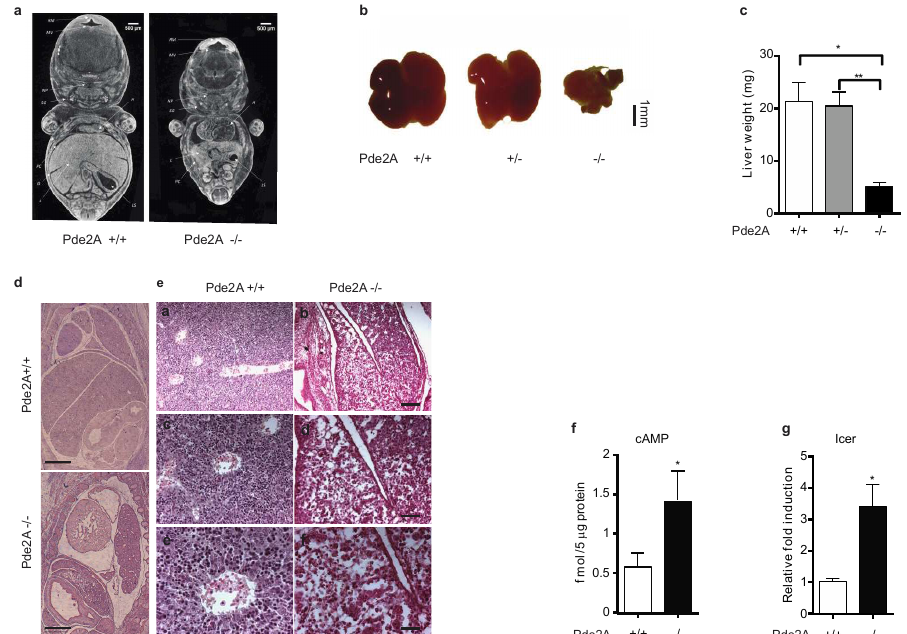
Figure 1. Morphological defects in liver of PDE2A − / − embryos. ( a ) Volume rendering visualization of coronal sections obtained from E14.5 PDE2A +/+ and PDE2A − / − embryos. Sections were chosen referring to the stomach lumen ( LS ) volume. H heart, L liver, PC peritoneal cavity, IS interlobular space, MV mesencephalic vesicle, SG submandibular gland, RM roof of midbrain, NP nasopharynx. ( b ) Representative stereomicroscope picture of livers isolated from E14.5 PDE2A +/+ , PDE2A +/ − and PDE2A − / − embryos. The liver of PDE2A − / − is hypoplastic. ( c ) Liver weight compared at E14.5 in PDE2A +/+ , PDE2A +/ − and PDE2A − / − embryos. ( d ) Histological analysis of E14.5 embryos stained with H&E. Scale bar 500 µ m. ( e ) Histological analysis of E14.5 liver sections stained with H&E. Scale bars: 200 µm (a,b), 100 µm (c,d) and 50 µm (e,f). ( f ) cAMP level in E 14.5 PDE2A + / + and PDE2A − / − livers. ( g ) Expression of ICER in livers of E14.5 PDE2A + / + and PDE2A − / − mice evaluated by qRT-PCR. At least N=3 embryos/genotype were analyzed in each experiment. * P < 0.05; ** P < 0.01. 2.2. Hepatic Markers Are Reduced Whereas Stromal and Endothelial Markers Are Increased in Liver Of PDE2A